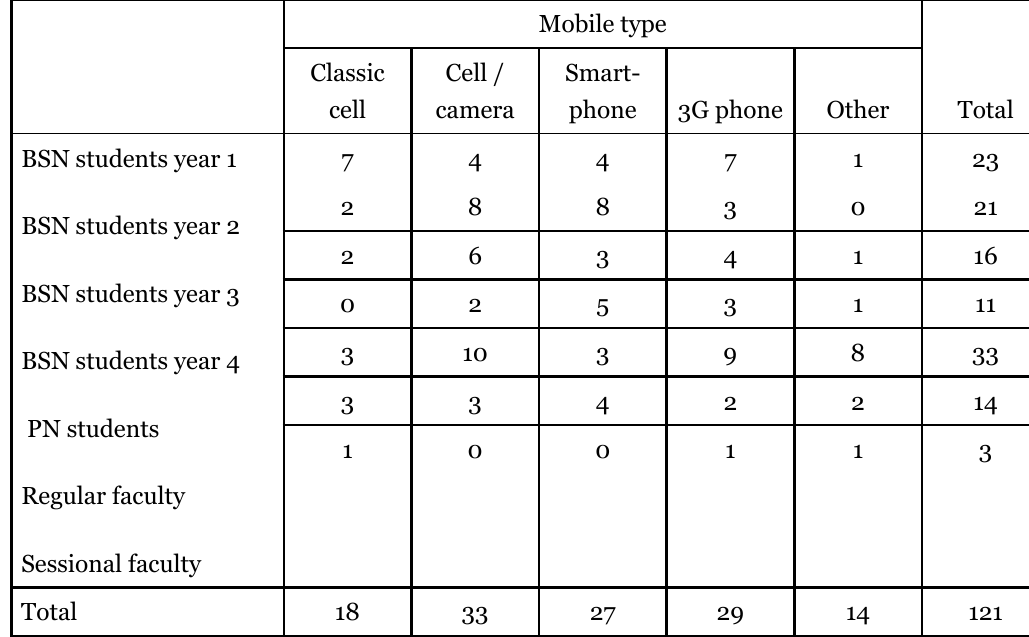
Type of Mobile Owned